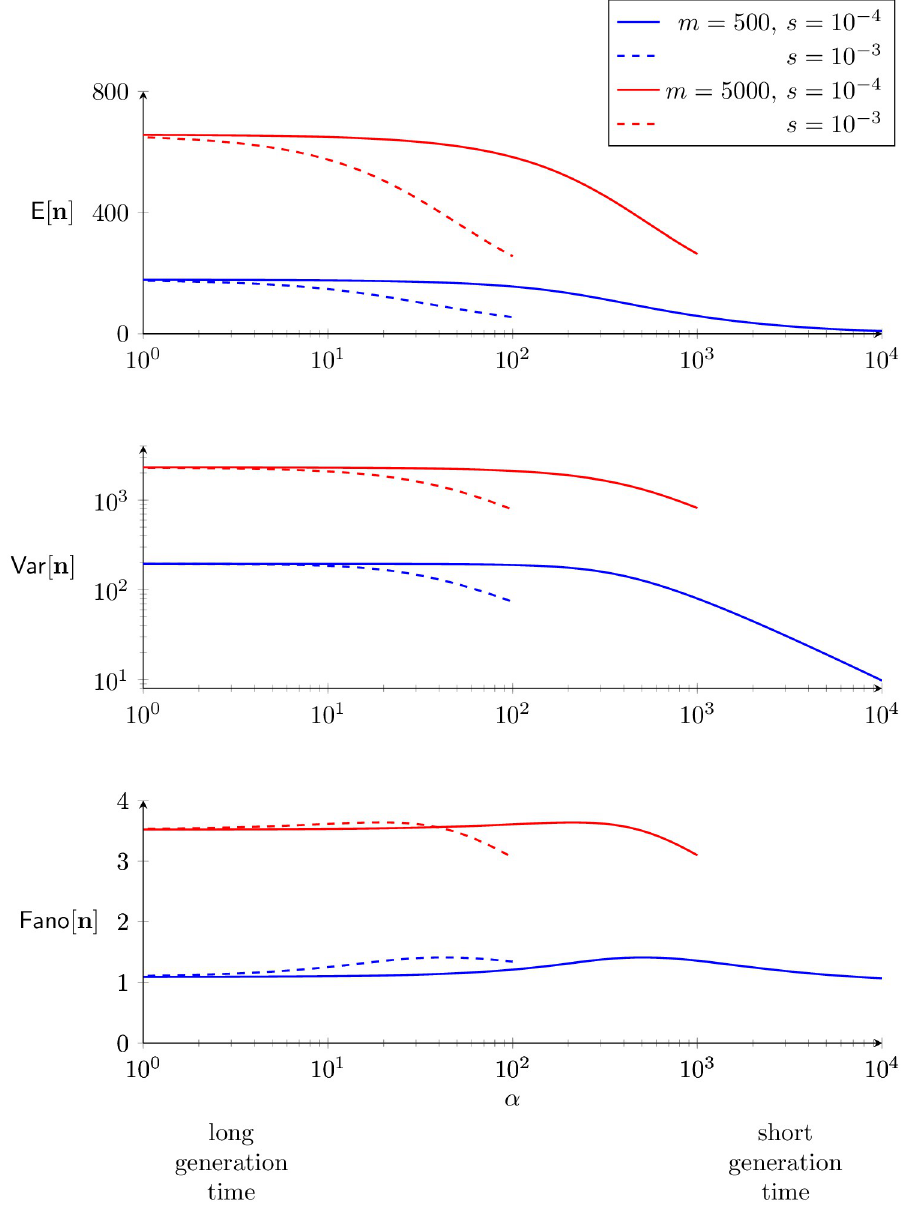
Fig 8. Statistics of TE load for weak selection depends on generation time. The moment equations derived under the assumption of weak selection, Eqs (33) and (34), with beta-binomial moment closure, Eq (39), enabled these parameter studies of the mean, variance, and dispersion of TE load as a function of generation time (1/ α ). Parameters: ν = 0.1, η 0 = 10, η = 0.1, and as in